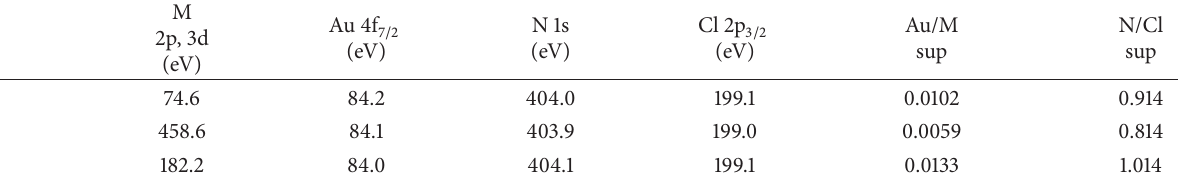
Table 3: Catalytic properties for the hydrogenation of CNB